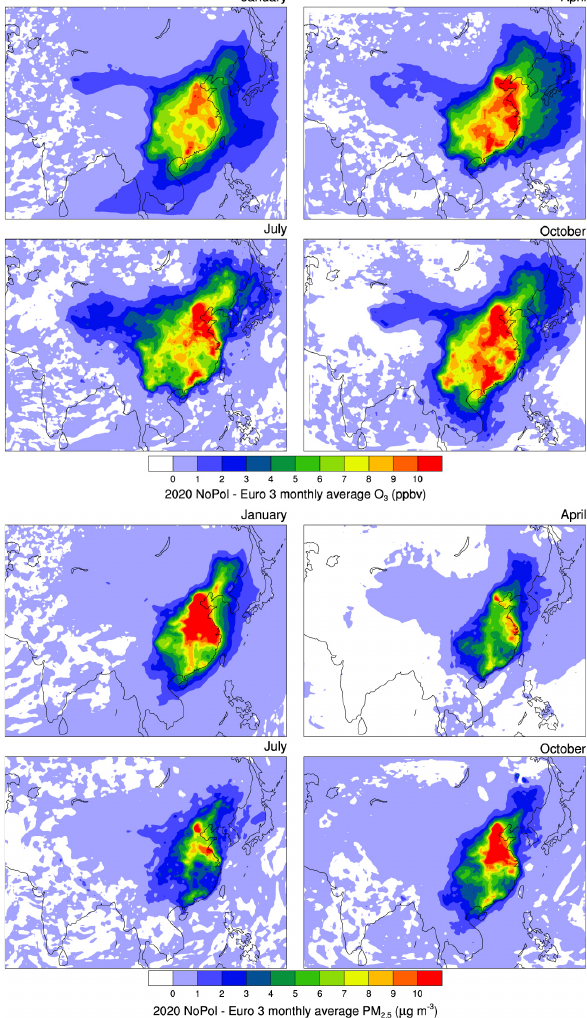
Fig. 12. Comparison of 2020 NoPol and 2020 Euro 3 (2020 NoPol– 2020 Euro 3) surface O 3 mixing ratios (ppbv) (top), and PM 2 . 5 con- centrations (µgm − 3 ) (bottom) in January, April, July and October modelled by